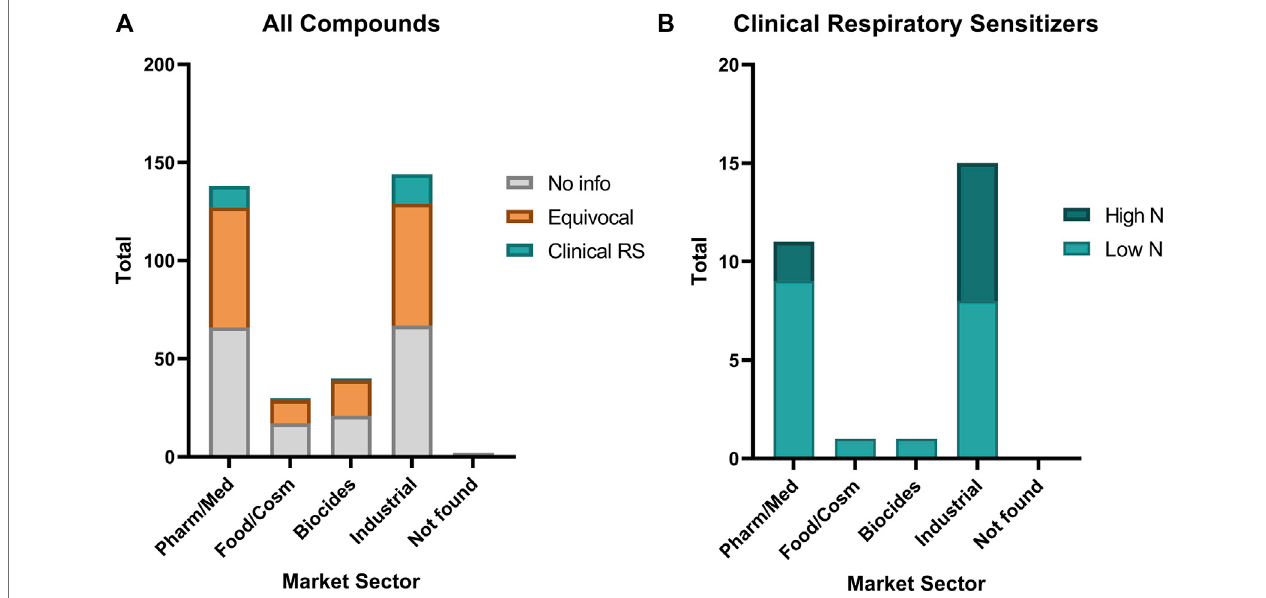
FIGURE 5 | Relative distribution of occupational sector of (A) all evaluated chemicals compared with (B) the identi fi ed clinical respiratory sensitizers (Clinical RS). A smallpercentage(2 — 10%)ofchemicalsineachmarketsectorrepresentedinourinvestigationwerefoundtobeclinicalrespiratorysensitizers.LowN:10orfewercases; High N: greater than 10 cases. Pharm/Med: pharmaceutical and medical. Food/Cosm: food and cosmetic. Biocides: insecticide, fungicide, antimicrobials, and other pesticides. Industrial: industrial materials, especially polymerizing agents. Not found: a market sector of use could not be identi fi ed for this compound in available public